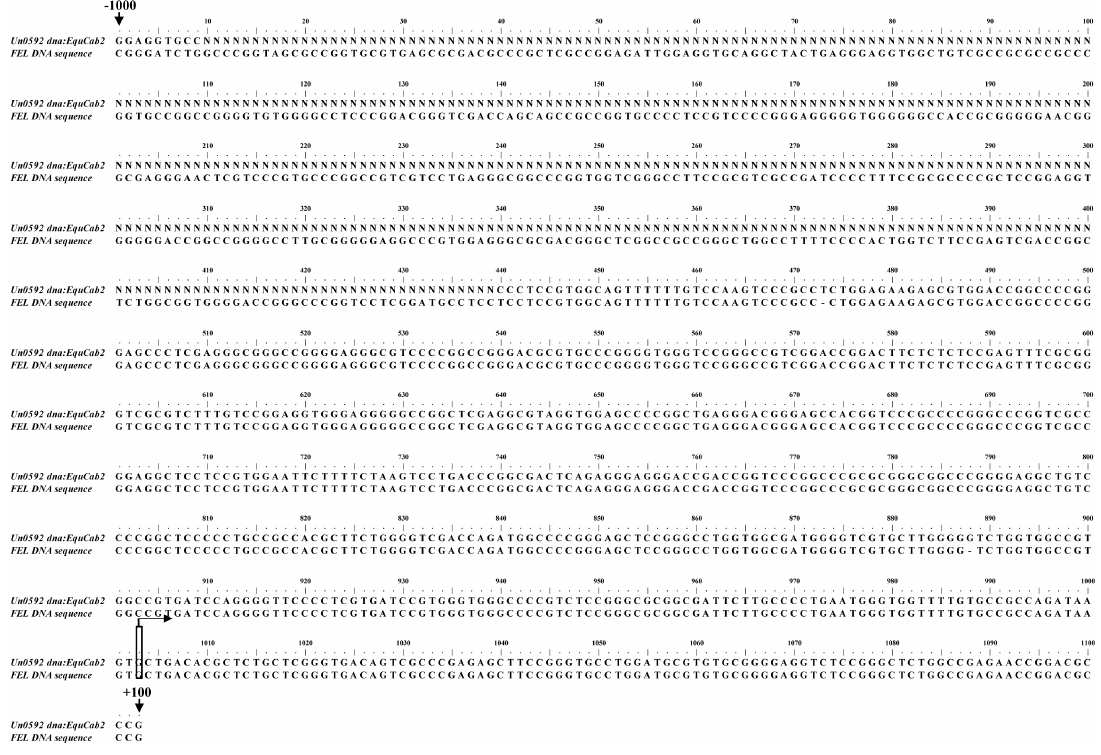
Figure 2. Alignment of the horse genomic DNA sequence (Un0591) and the cloned genomic DNA sequence from FEL cells in our study. The transcription initiation site is labeled as +1. The − 1000 and +100 positions of the horse RNA PolI transcription initiation site are shown by arrows.